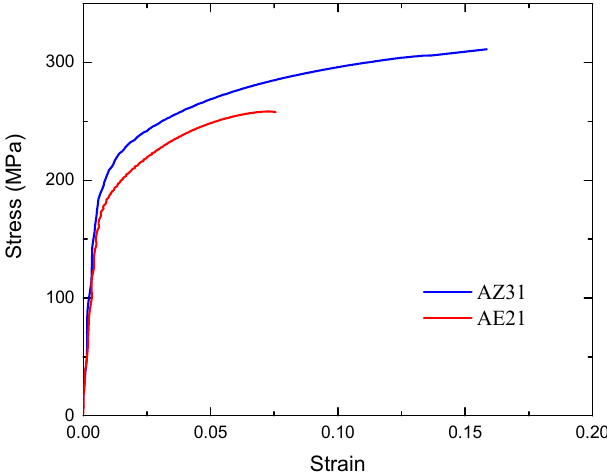
Figure 2. Tensile stress-strain curves of the magnesium alloys AZ31 and AE21.